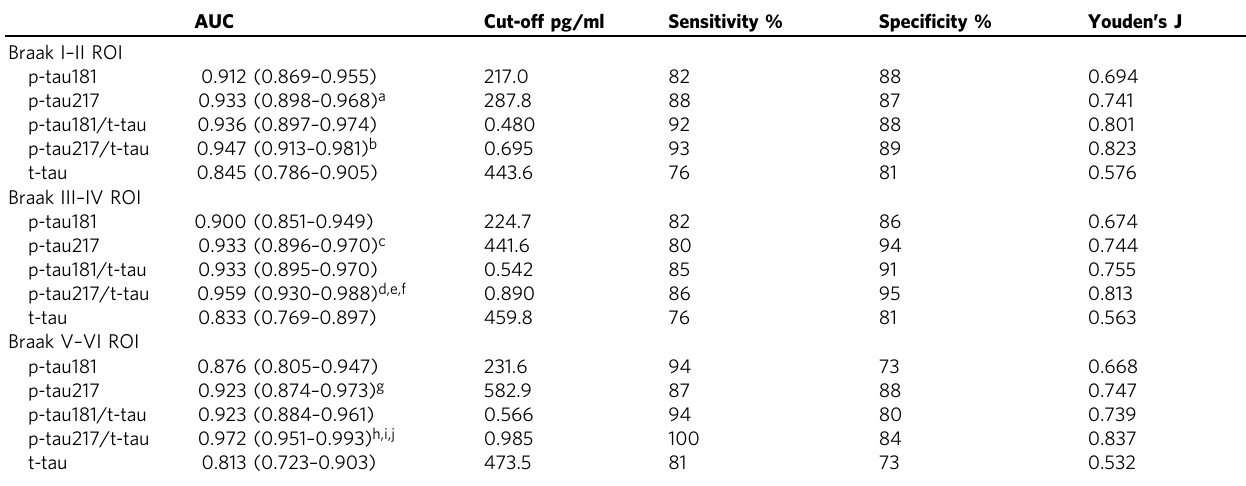
Table 3 ROC analysis of CSF tau variants for identifying abnormal [ 18 F] fl ortaucipir status. AUC Cut-off